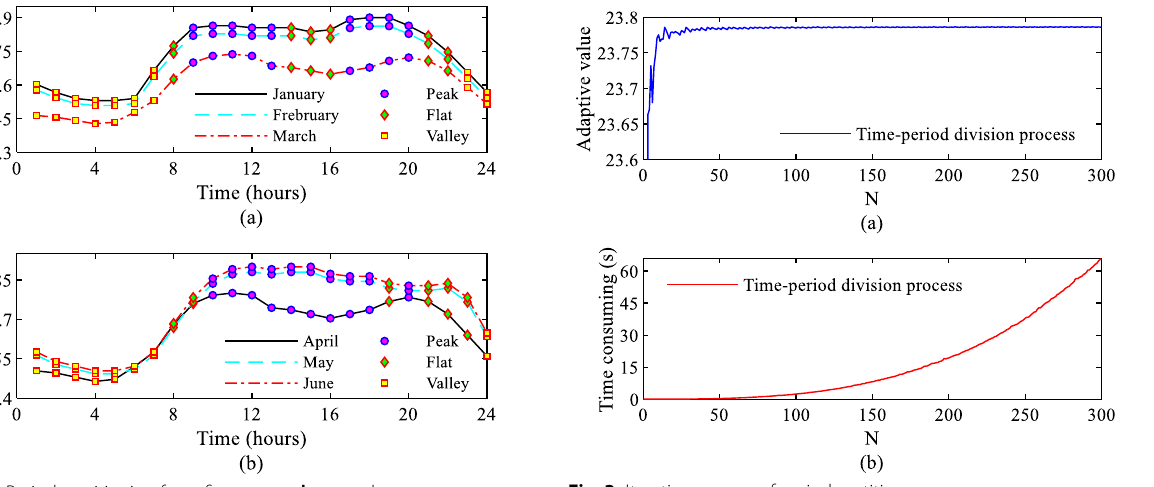
Fig. 1 Period partitioning for: a first quarter b second quarter